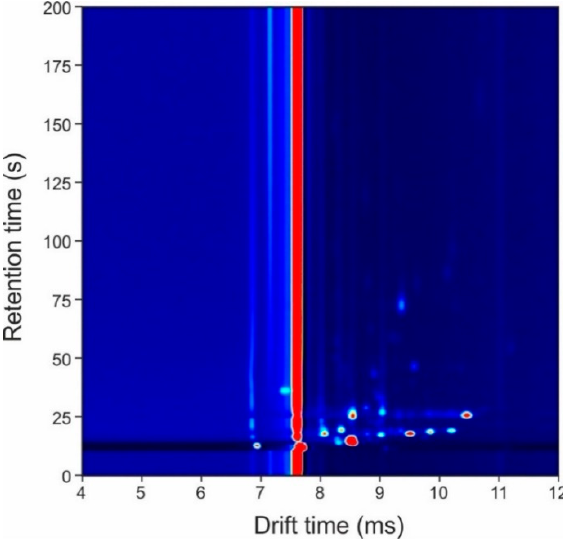
Figure 2. Typical output plot from the gas chromatography-ion mobility spectrometry (GC-IMS) Figure 3 provides an example output from the GC-TOF-MS method. Here, the x -axis Figure 2. instrument. refers to the retention time, and the y -axis, the total ion count. (GC-IMS) instrument.